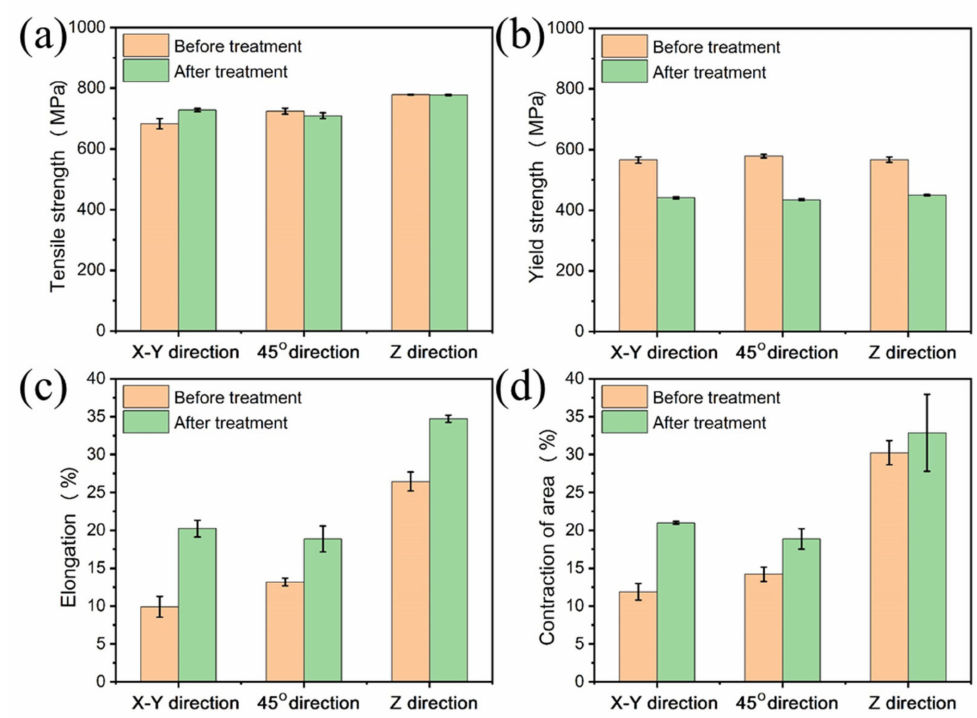
Figure 3. Room − temperature tensile properties of samples before and after heat treatment: ( a ) tensile strength; ( b ) yield strength; ( c ) elongation; and ( d ) the contraction of